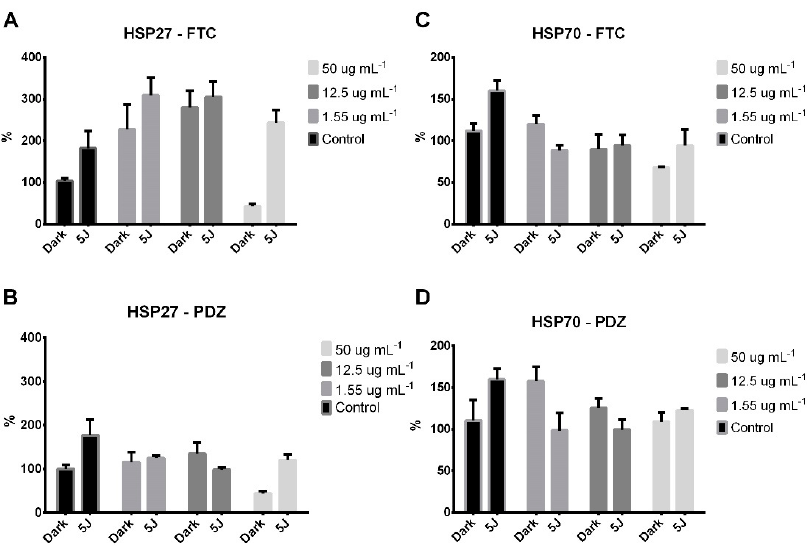
Figure 6. Analysis of HSP27 protein expression before and after PDT in the fluence of 5 J/cm 2 . ( A )—Expression of HSP27 in PDT with FTC at concentrations of 1.55 µg mL − 1 , 12.5 µg mL − 1 , and 50 µg mL − 1 . ( B )—Expression of HSP27 in PDT with PDZ at concentrations of 1.55 µg mL − 1 , 12.5 µg mL − 1 , and 50 µg mL − 1 . Analysis of HSP70 protein expression before and after PDT in the fluence of 5 J/cm 2 . ( C )—Expression of HSP70 in PDT with FTC at concentrations of 1.55 µg mL − 1 , 12.5 µg mL − 1 , and 50 µg mL − 1 . ( D )—Expression of HSP70 in PDT with PDZ at concentrations of 1.55 µg mL − 1 , 12.5 µg mL − 1 , and 50 µg mL − 1 .